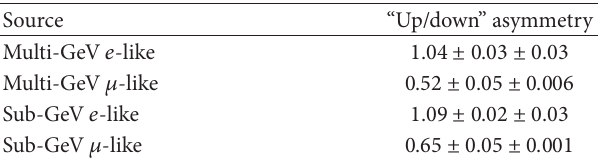
Table 3: The “up/down” asymmetry for muons and electrons observed in Super-Kamiokande [16]. Here, “up” refers to incident neutrinos within the zenith angle range −1 < cos 𝜃 < −0.2 and “down” within 0.2 < cos 𝜃 < 1